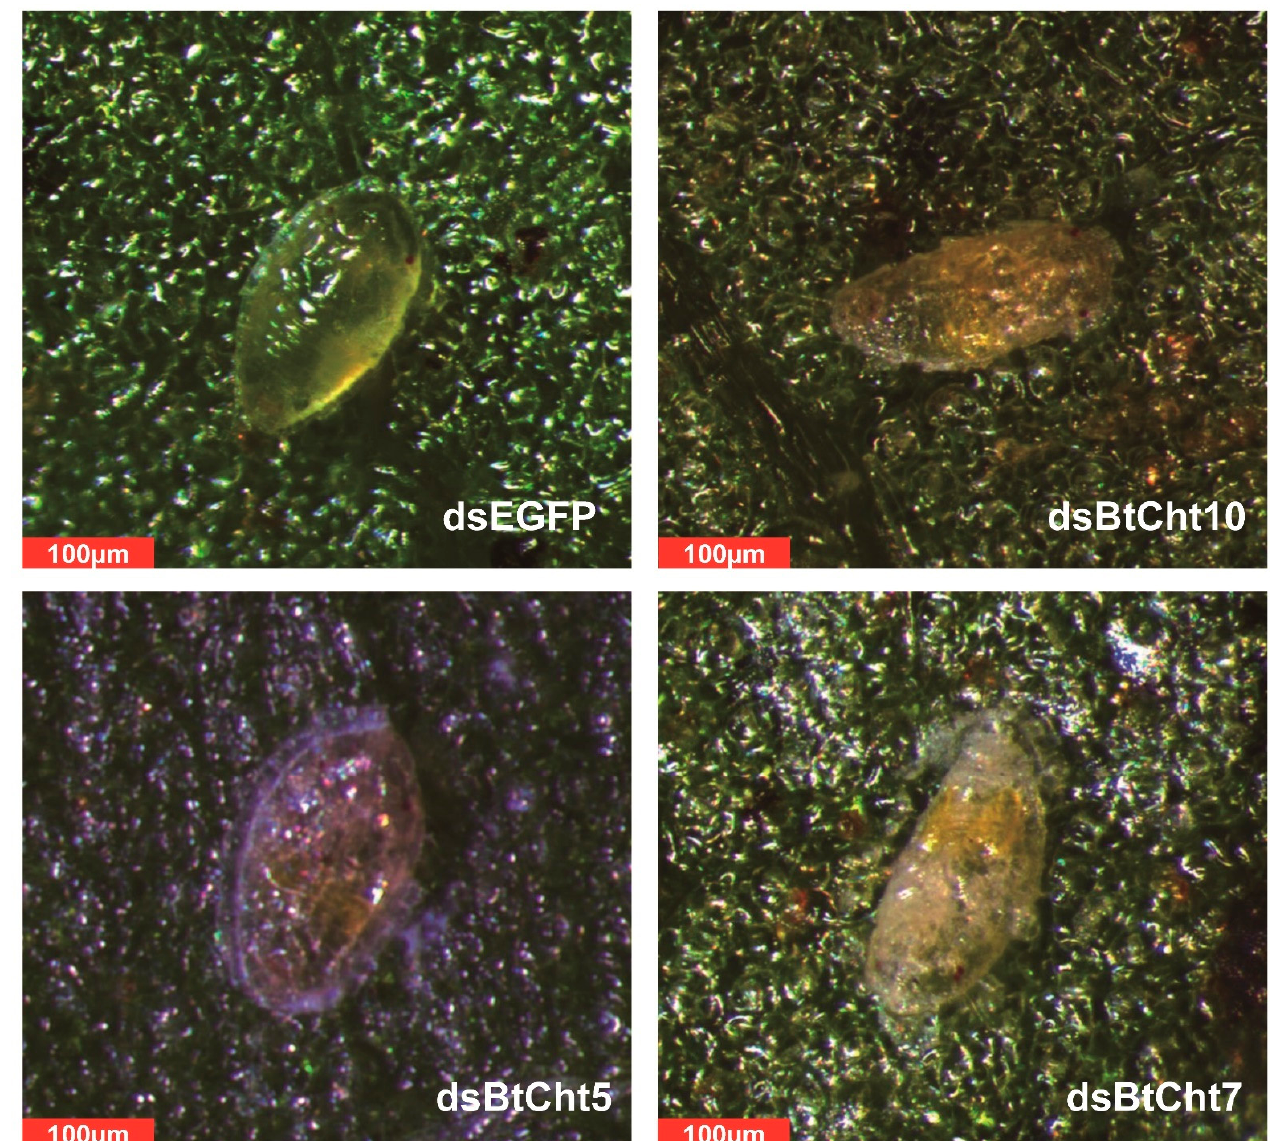
Figure 7. Lethal phenotypes of nymphs treated with dsRNA for B. tabaci chitinases (BtChts). dsRNA targeting gene of enhanced green fluorescent protein (EGFP) was used as negative control. Nymphs treated with ds BtCht10 , ds BtCht5 and ds BtCht7 exhibited similar phenotypes and high mortality.